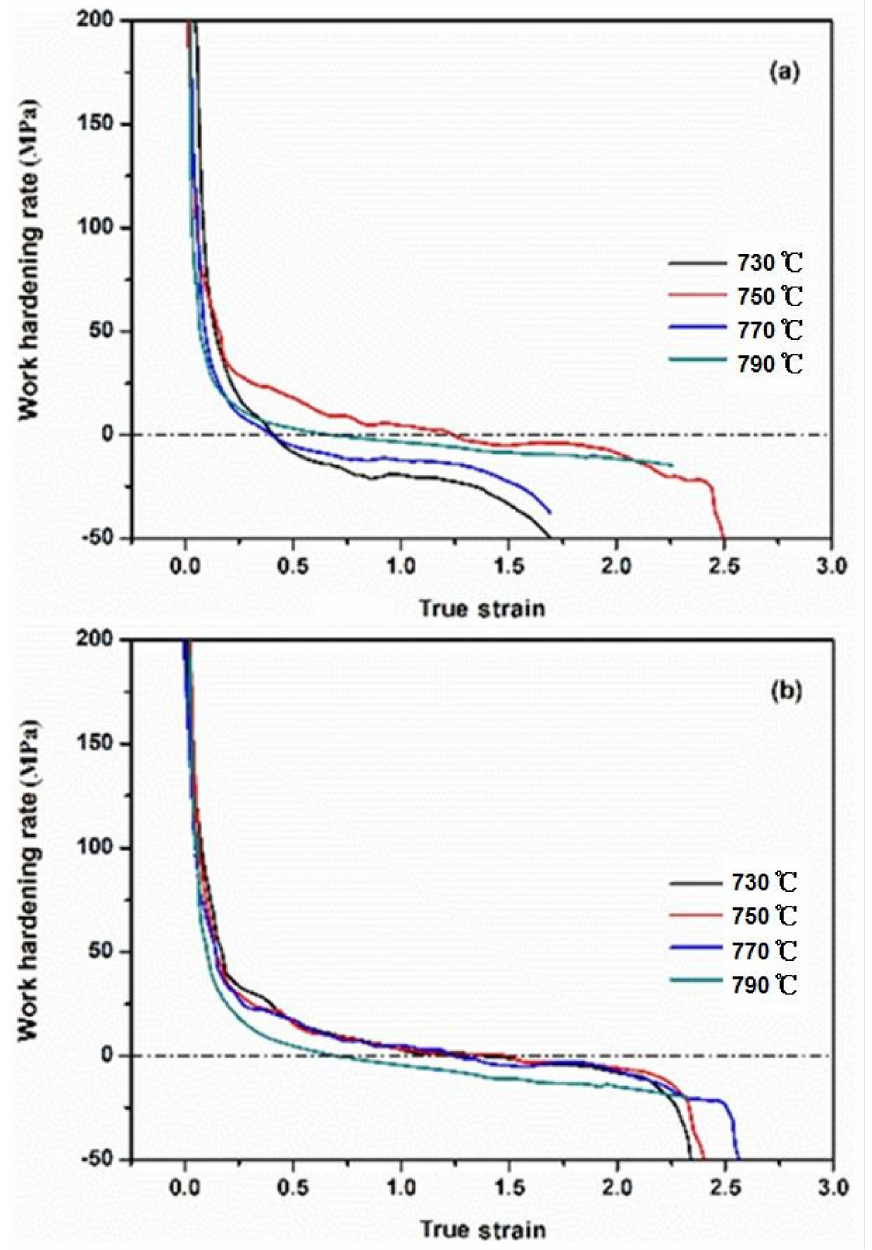
Figure 6. The work hardening rate curves of the forged ( a ) SP700 and ( b ) SP700Cr